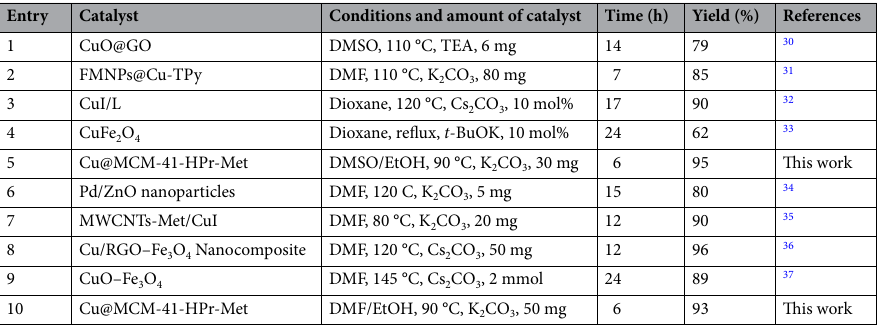
Table 7. Comparison of the results obtained in the synthesis of diaryl sulfides (1–5) and diaryl ethers (6–10) in the presence of Cu@MCM-41-HPr-Met and other catalysts.